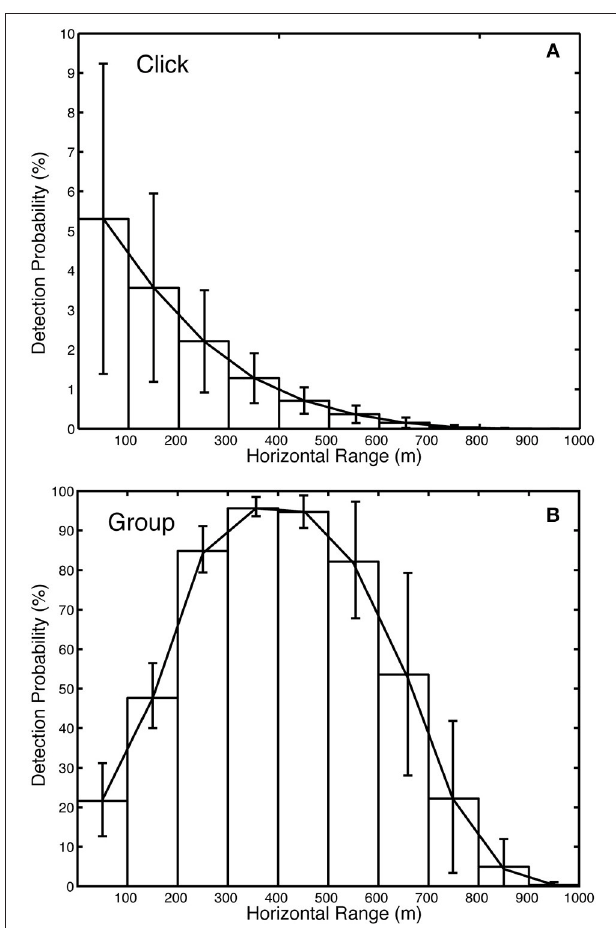
FIGURE 8 | Detection probability versus range for Kogia spp. (A) individual echolocation clicks and (B) groups during a one-min bin. Total detectability 8.7% for site MC. ± 0.290% and for groups is 43.4 ± …within 1,000 m for clicks is